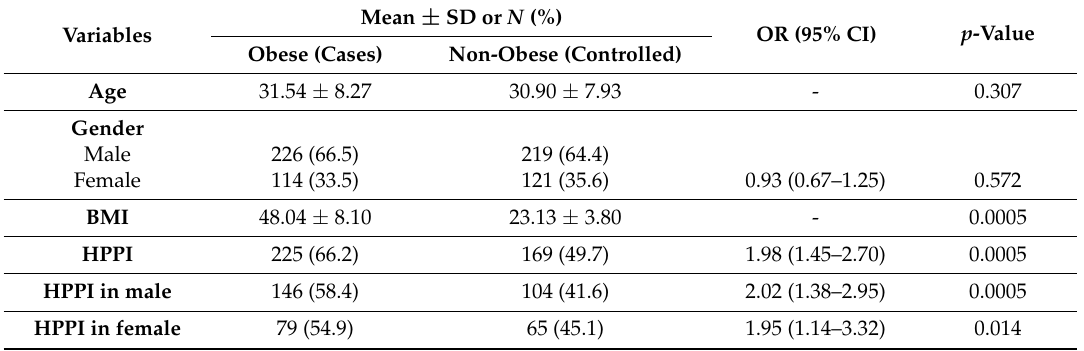
Table 1. Characteristics of obese ( N = 340) and none-obese ( N = 340) and distributions of HPPI between groups and gender.